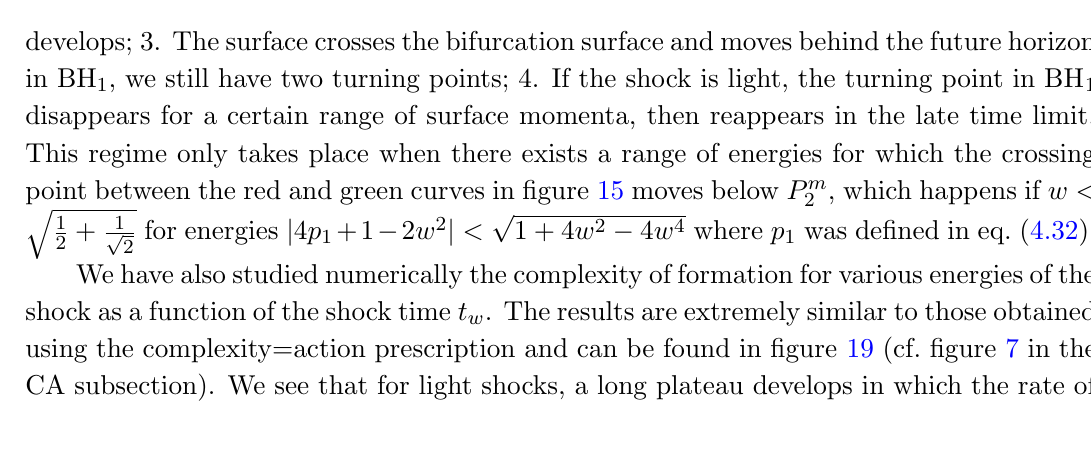
Figure 17. Time derivative of the complexity evolved with symmetric boundary times t t= 2 as a function of T 2 t normalized by the sum of masses for (cid:12)nite size shocks with w = 2 for BTZ black holes (i.e., d = 2) for T 2 t w = 2 (left) and T 2 t w = 6 (right). The horizontal dashed lines indicate the limits (4.22), (4.23) and (4.25). We see that the late time limit is approached